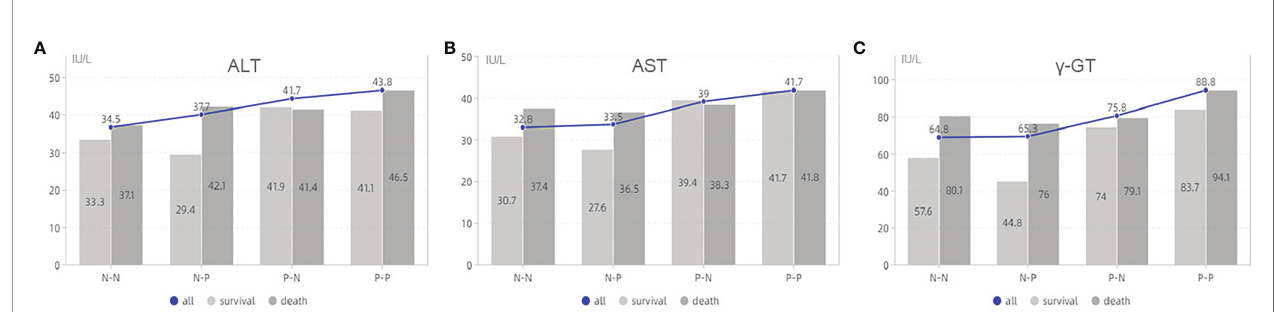
FIGURE 4 | The analysis of laboratory data based on AFP alteration. (A) is the association between ALT and survival status based on groups; (B) is the association between AST and survival status based on groups; (C) is the association between g -GT and survival status based on groups. ALT, alanine aminotransferase; AST, aspartate aminotransferase; g -GT, g -glutamyl transpeptidase; N-N, negative AFP at baseline and negative AFP at relapse; N-P, negative AFP at baseline and positive AFP at relapse; P-N, positive AFP at baseline and negative AFP at relapse; P-P, positive AFP at baseline and positive AFP